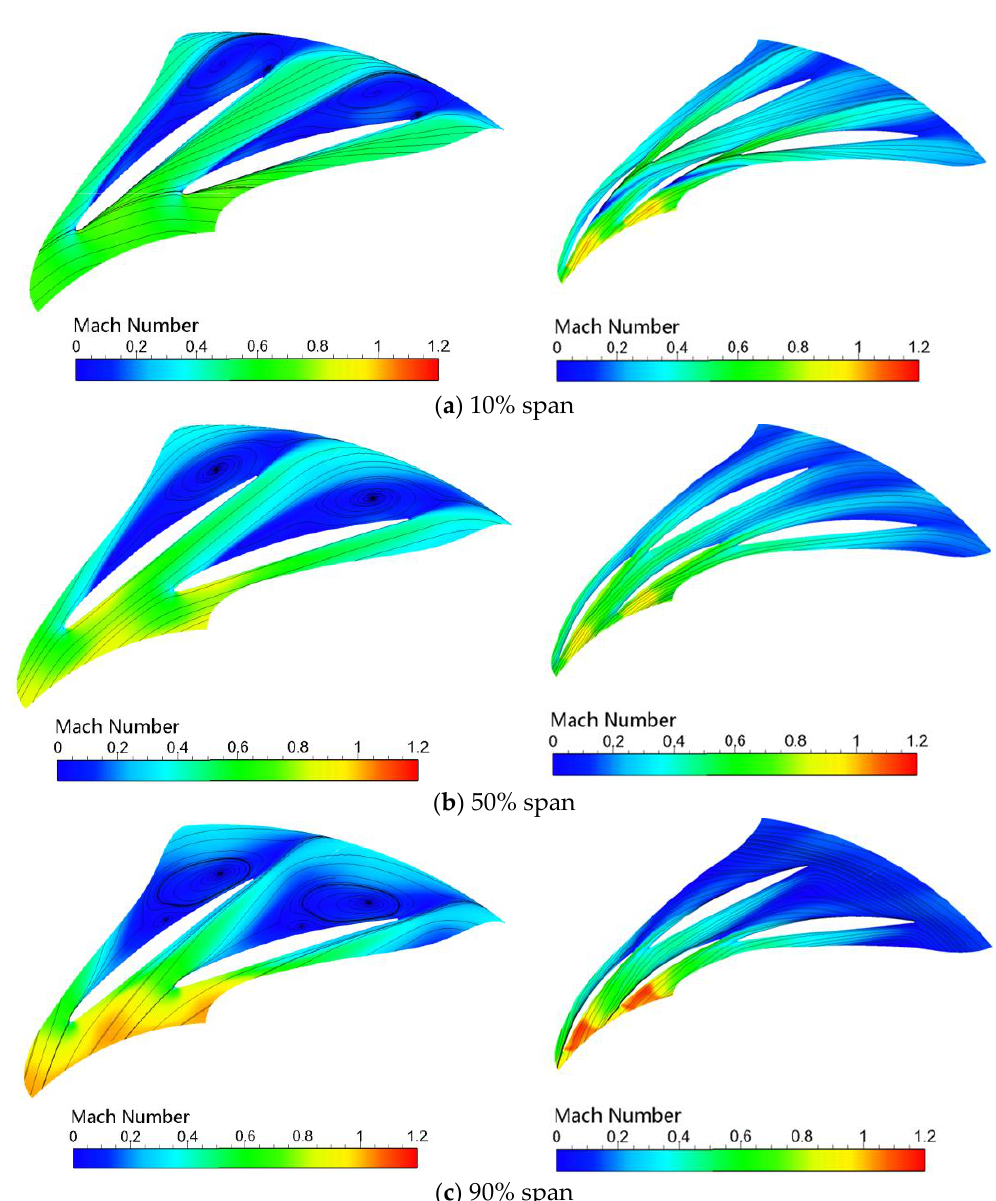
Figure 15. Mach number distribution at different spans of the original and optimized designs of the low-pressure-stage centrifugal compressor at 100% load.